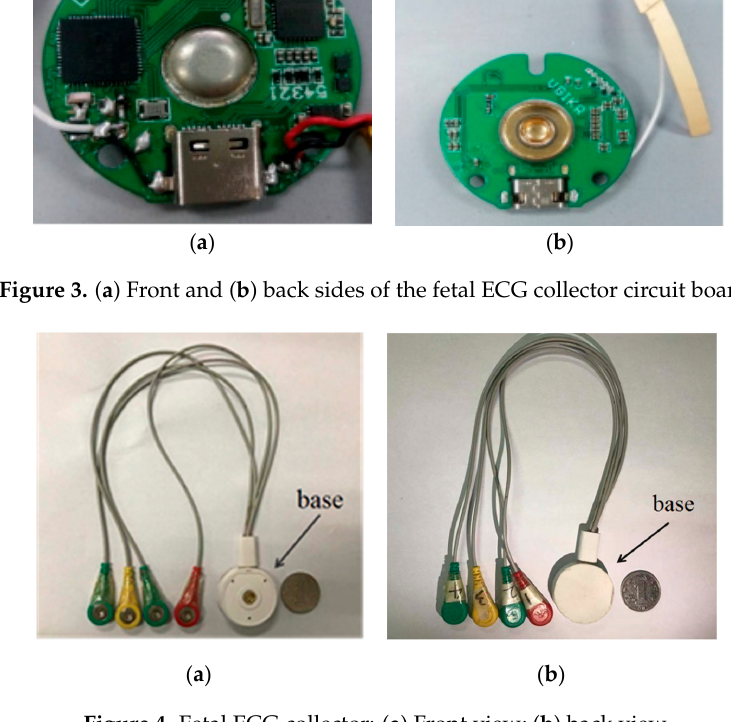
Figure 4. Fetal ECG collector: ( a ) Front view; ( b ) back view.